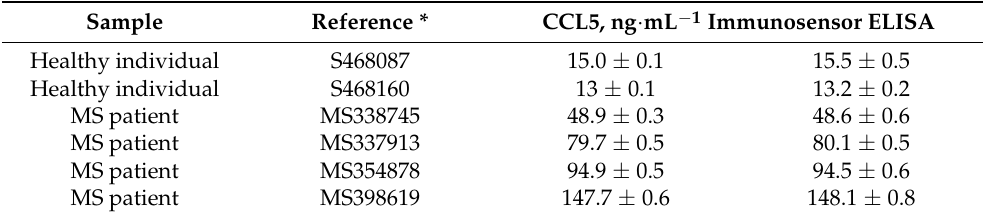
Table 2. Determination of endogenous CCL5 concentration in serum of healthy individuals and MS